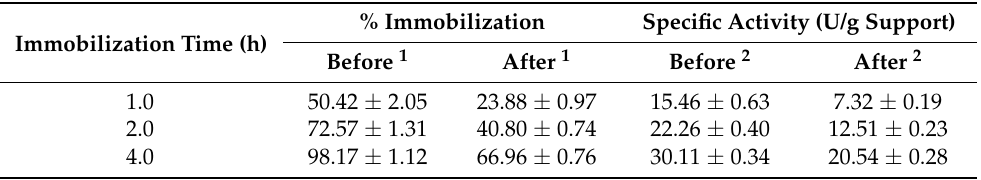
Table 2. Effect of time on immobilization of β -glucosidase (E-BGOSPC) on glyoxyl agarose and pH-reduction on enzyme activity, pH 8.5, with N -acetylcysteine, at room temperature. % Immobilization Specific Activity (U/g Support) Immobilization Time (h) Before 1 After 1 Before 2 After 2 1.0 50.42 ±